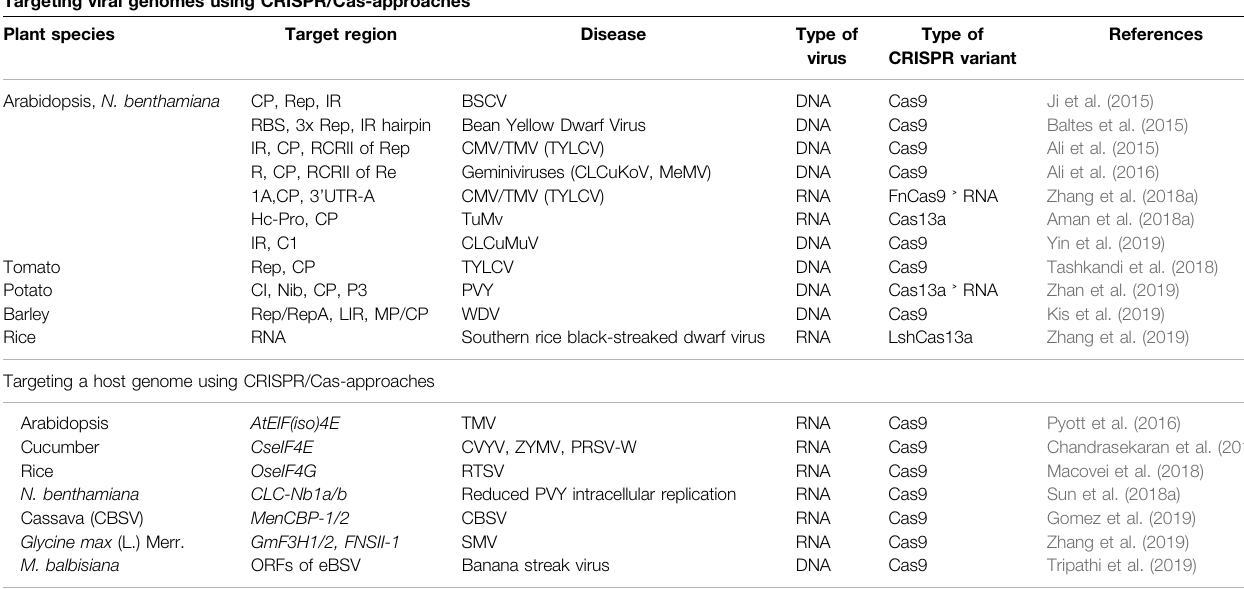
TABLE 2 | Successful applications of CRISPR/Cas-mediated genome editing for enhancing plant resistance against